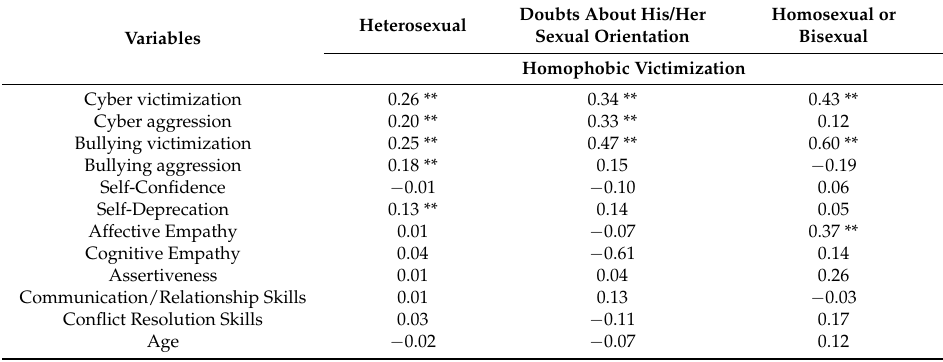
Table 1. Matrix of bivariate correlations between the variables by sexual